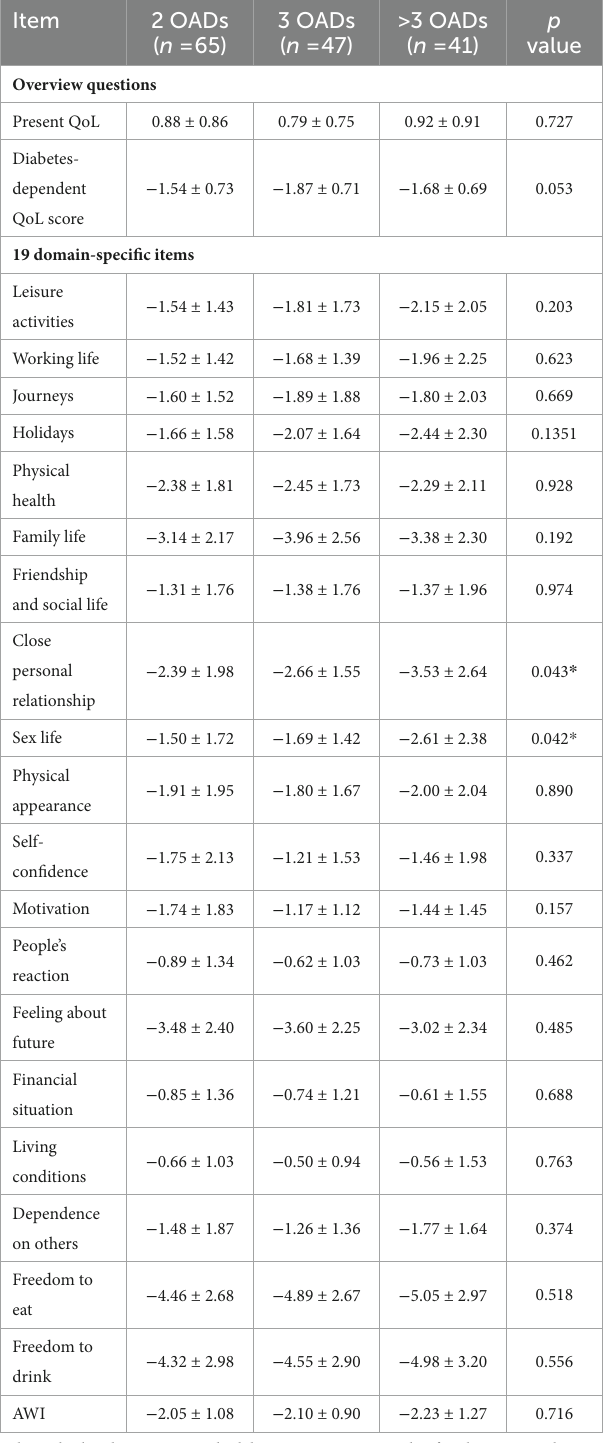
TABLE 3 ADDQoL score in different oral antidiabetic drug groups. TABLE 4 C-SOADAS in different oral antidiabetic drug